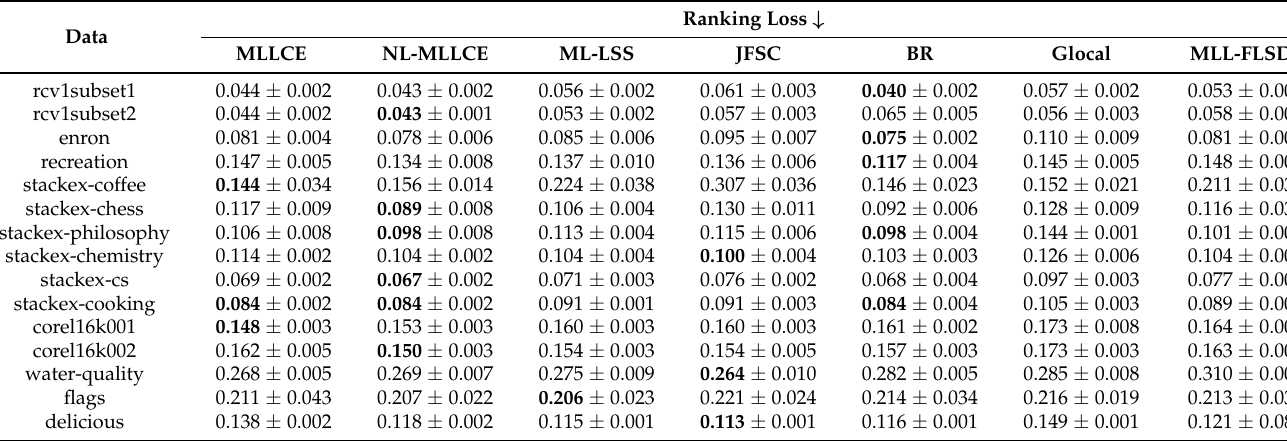
Table 5. The experimental results (mean ± standard) of all comparison methods in this paper in terms of Ranking Loss. ↓ means that the smaller the value, the better the performance is. The best results in each row are highlighted in bold face.